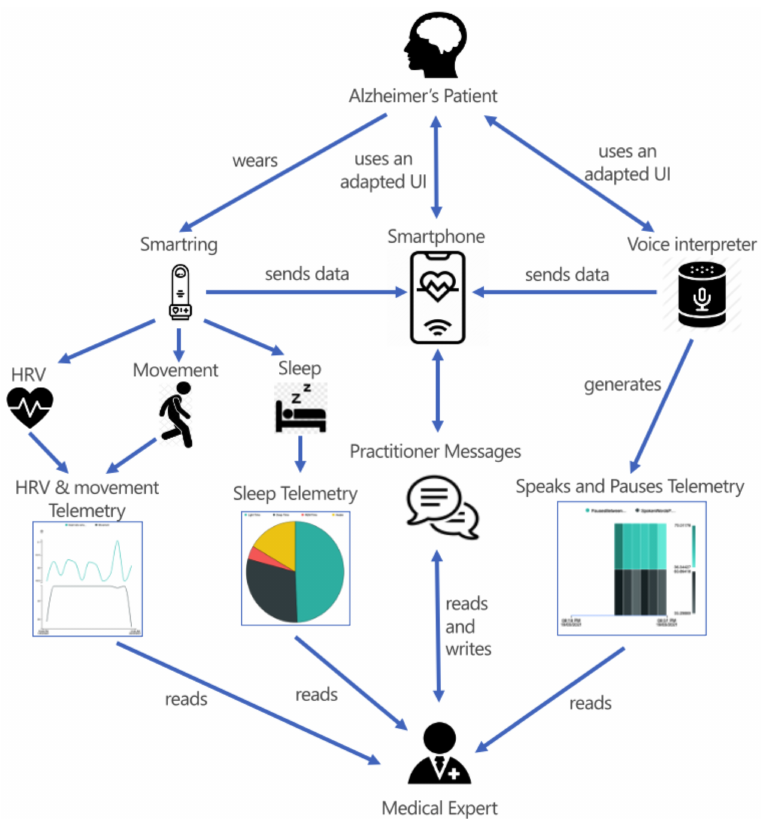
Figure 10. Data flow diagram of the Alzheimer’s